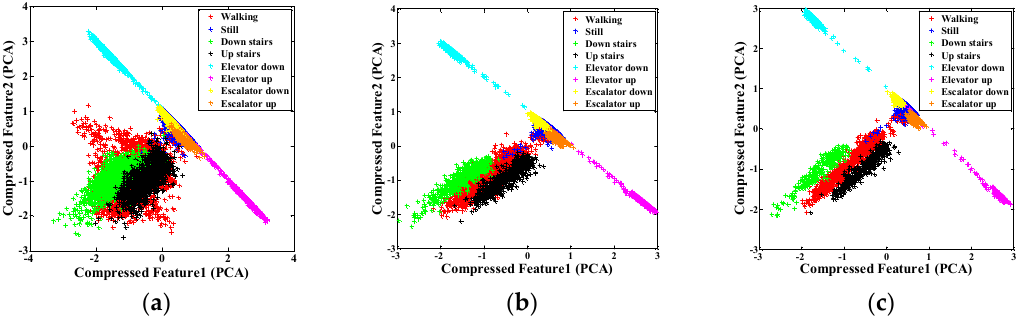
Figure 5. Distribution of compressed features of human motion modes with various window lengths: ( a ) 1 s; ( b ) 2 s; and ( c ) 3 s.